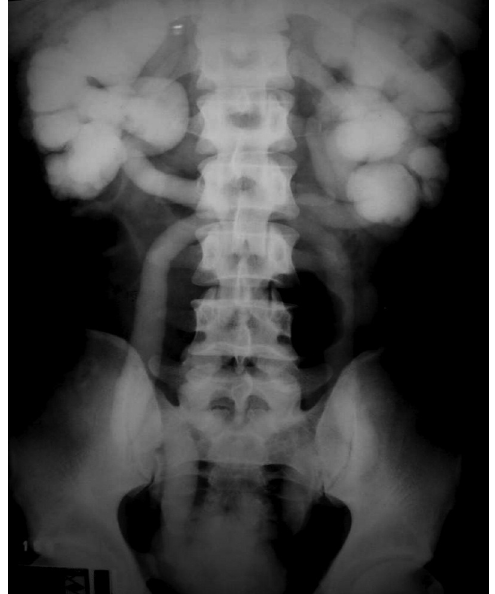
Figure 1 – Intravenous urography showing bilateral ureterohydronephrosis and delayed contrast excretion. (150